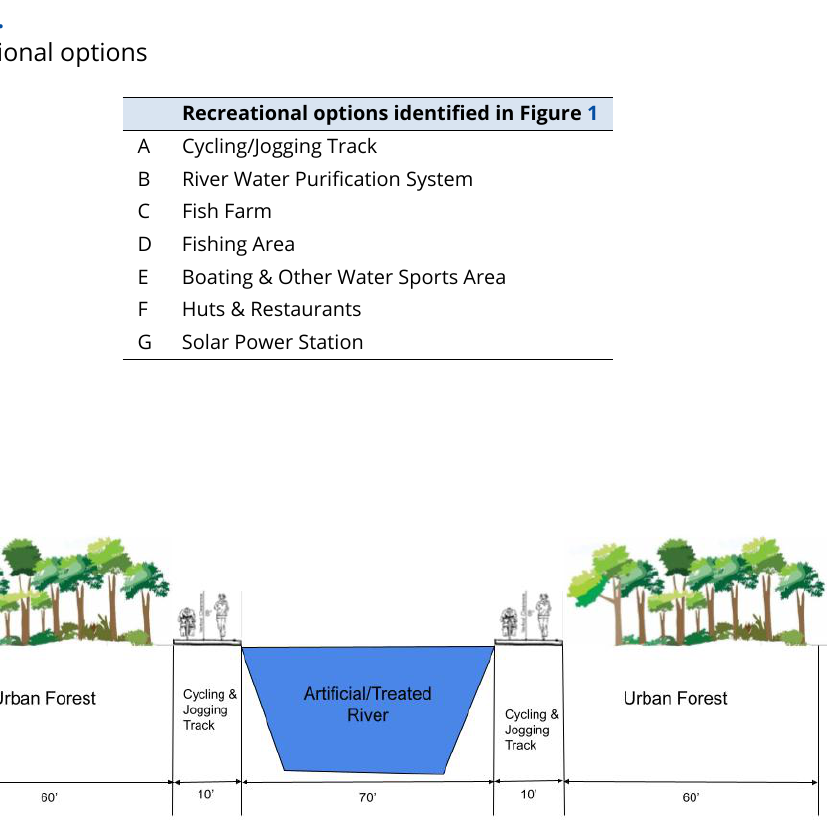
is collected from mostly professionals and students residing in